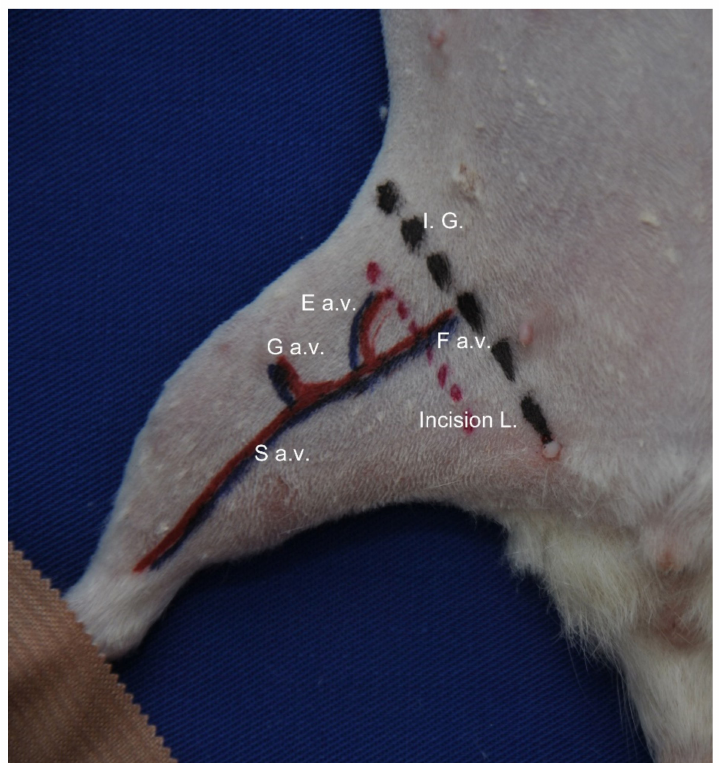
Figure 1. Preoperative marking of the incision area. The anesthetized animal was placed on the surgery board in the ventral position with hindlimbs immobilized in extension. Marking of the right hindlimb was as follows: I. G.—skin projection of the inguinal ligament; Incision L.—the projection of future skin incisions; F a.v.—femoral artery and vein; E a.v.—epigastric artery and vein; G a.v.—geniculate artery and vein; S a.v.—saphenous artery and